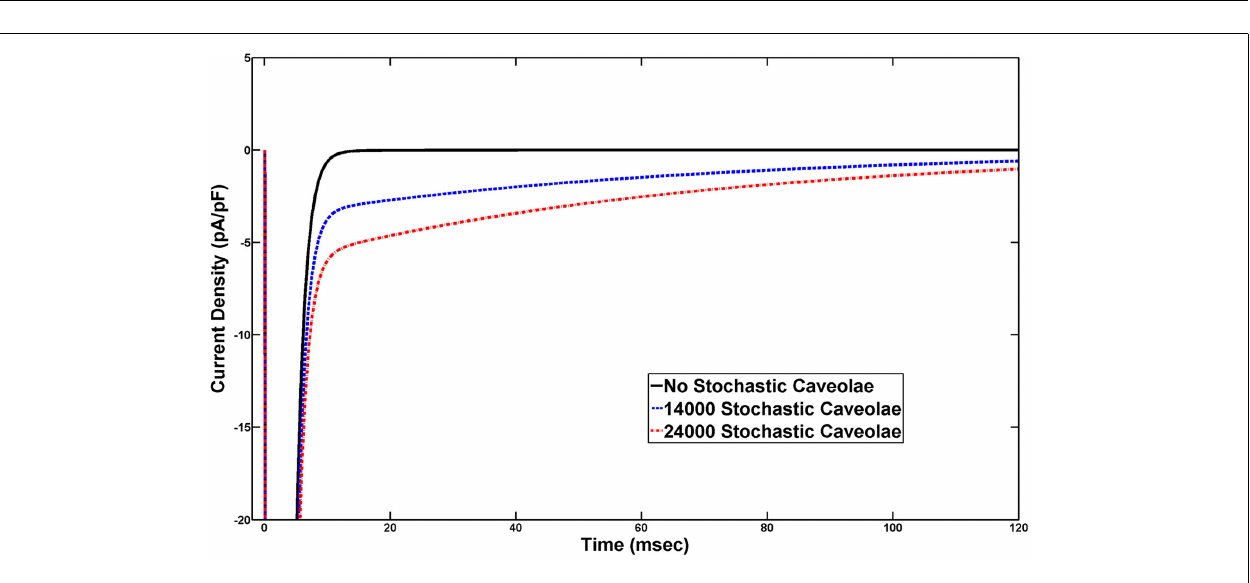
FIGURE 5 | Effects of caveolar density variation on ionic current time courses for λ fixed. In this scenario, we have fixed λ at 15 and have superimposed plots of (A) the transient sodium current, I (B) the potassium current, I t , (C) the caveolar sodium current, I cav , and (D) the L-type calcium current, I CaL , associated with 14000, 16000, and 18000 stochastic caveolae.When 16000 and 18000 caveolae are included, calcium